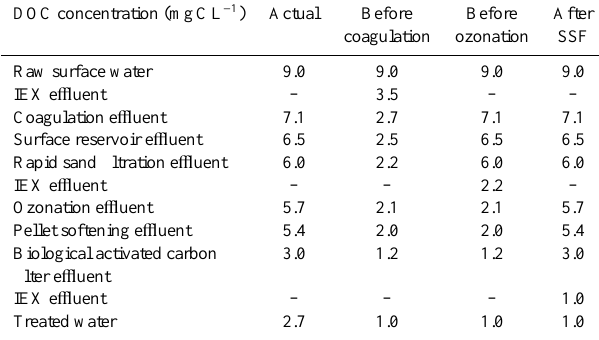
Table 1. The expected variation of dissolved organic carbon (DOC) across the treatment train (based on Baghoth et al., 2009).